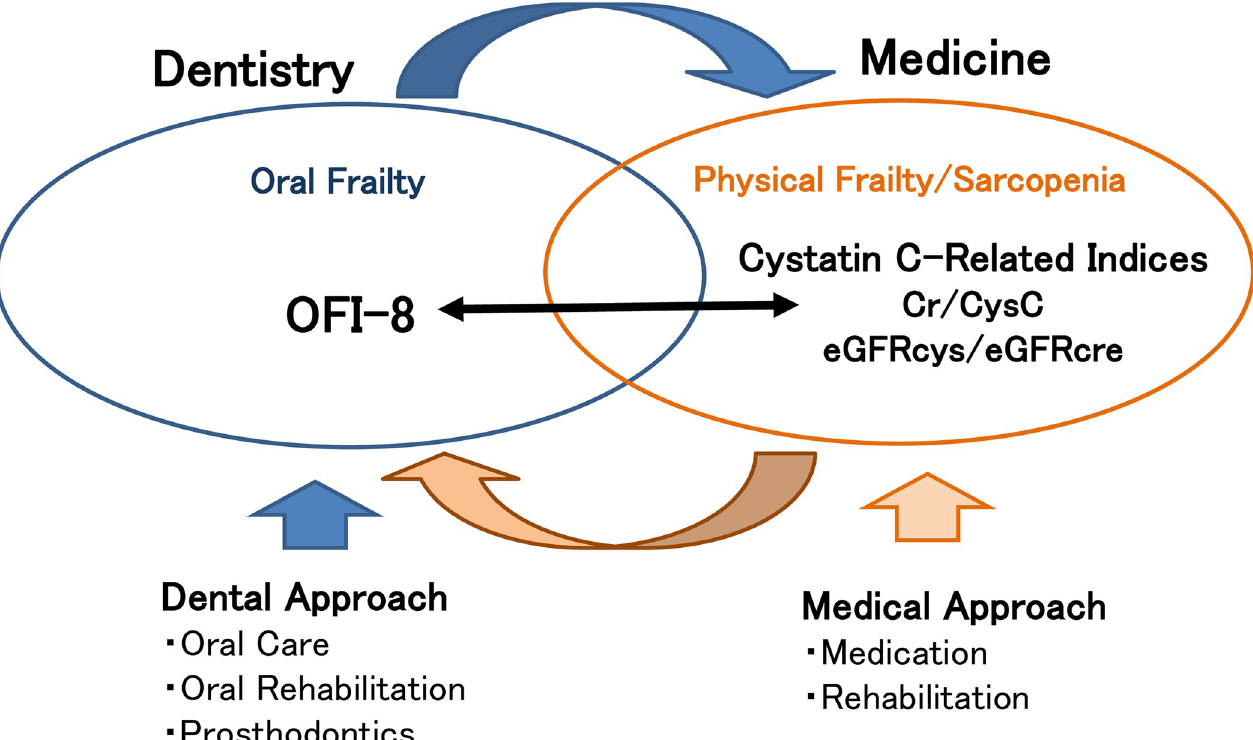
Fig 3. Image of OFI-8 and cystatin C-related indices in medical-dental cooperation.